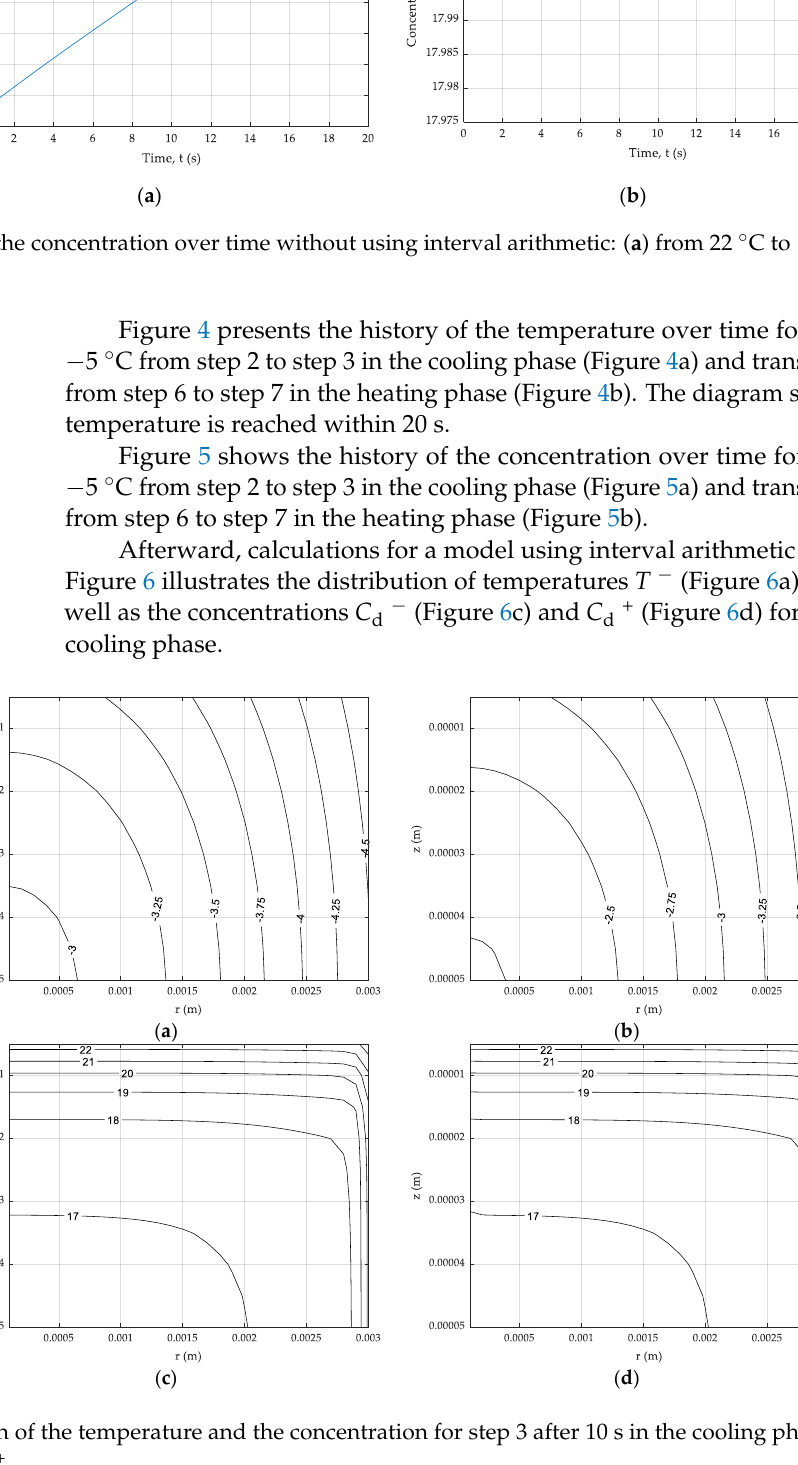
phase (Figure 7b).